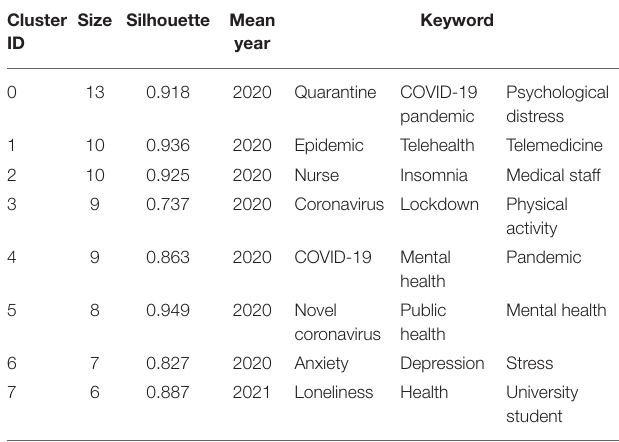
TABLE 5 | Keyword clustering II. Cluster Size Silhouette Mean ID